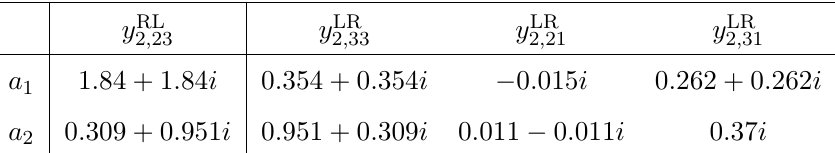
Table 1 . Non-zero Yukawa couplings for two benchmark points in a model that includes a single R 2 leptoquark species (with a mass of 1 TeV), and that provides an explanation for the flavour anomalies according to [99]. The two points have been selected from the 1 σ ranges of model parameters allowing us to explain the anomalies.